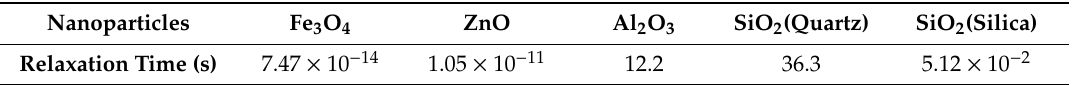
Table 2. Relaxation time of indicative nanoparticles adapted from Hwang et al.